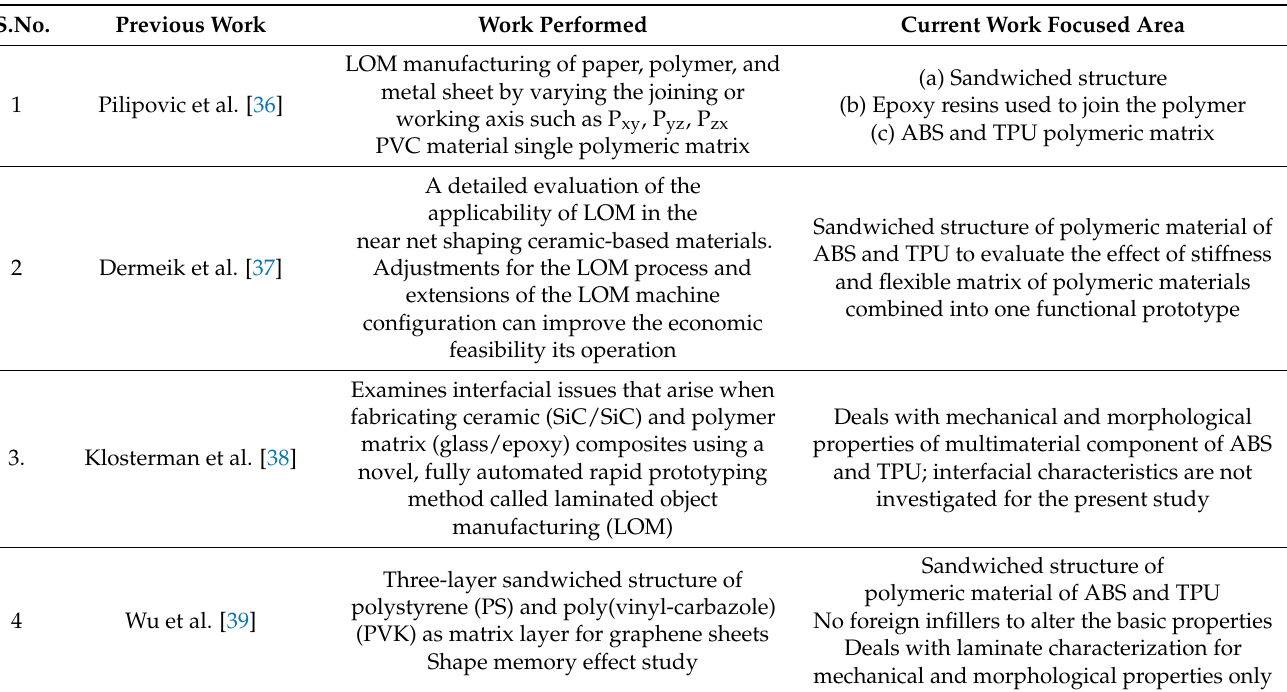
Table 1. Previous studies performed based on